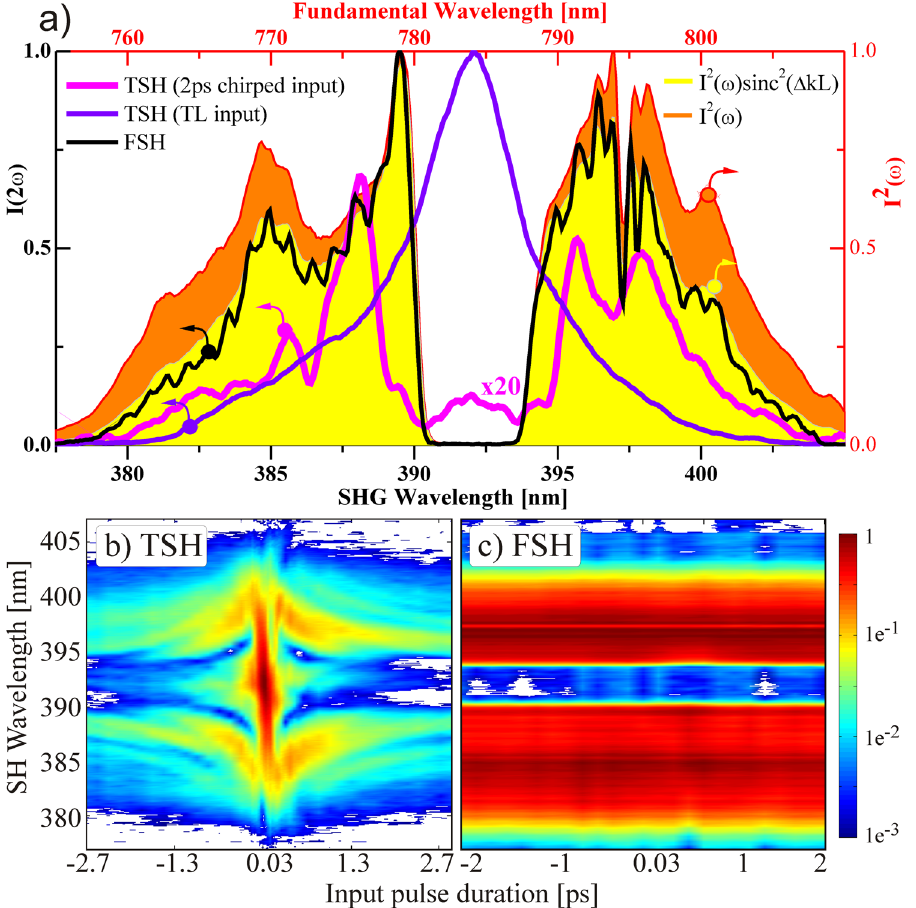
Figure 4. Investigating amplitude and phase coupling as a function of chirp. The amplitude of the fundamental was shaped according to the filled orange curve in ( a ), which shows the square of the input intensity. TSH ( c ) exhibits a strong dependence of the spectral amplitude as a function of input chirp. Because this amplitude- phase coupling is absent in FSH ( c ), all SH spectra remain constant, like the black line in ( a ). All spectral features transfer directly to the